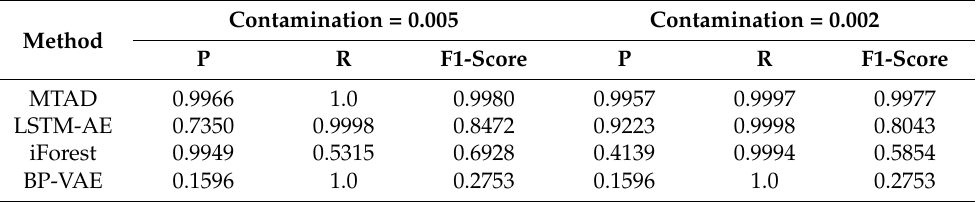
Table 3. Detection performance of alternative methods and the proposed MTAD method.